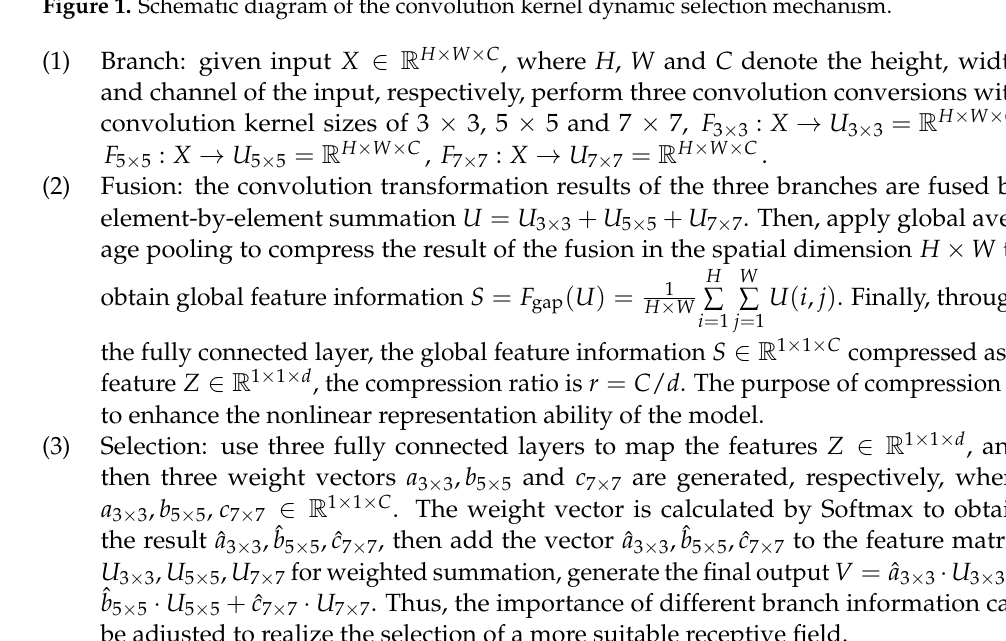
Figure 1. Schematic diagram of the convolution kernel dynamic selection mechanism.